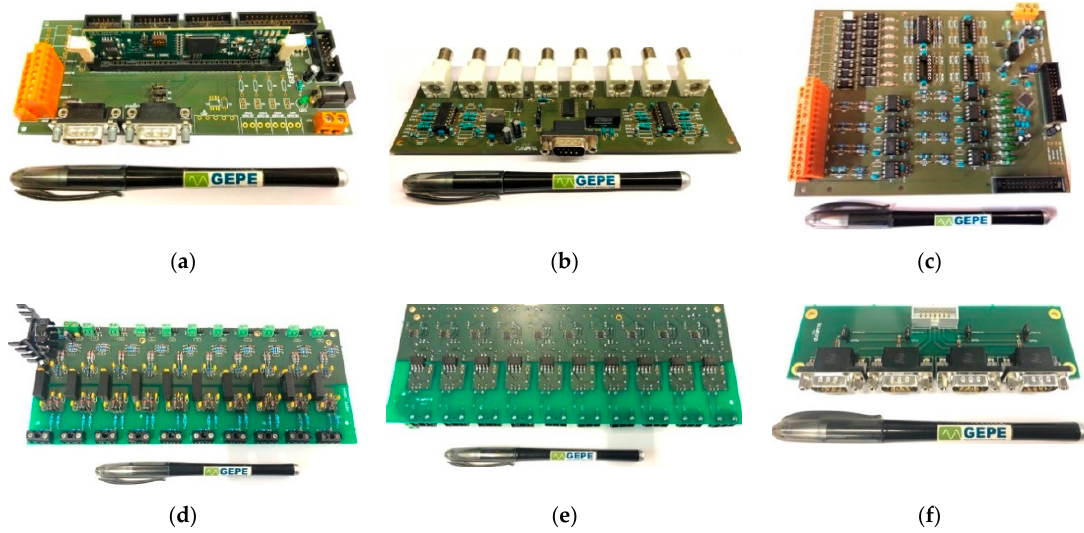
Figure 13. Some of the control system boards: ( a ) digital signal processor (DSP) board; ( b ) digital-to-analogue converter (DAC) board; ( c ) Signal conditioning board for the external analogue-to-digital converter (ADC); ( d ) Signal conditioning board for the internal ADC—top view; ( e ) Signal conditioning board for the internal ADC—bottom view; ( f ) pulse width modulation (PWM) adapter.